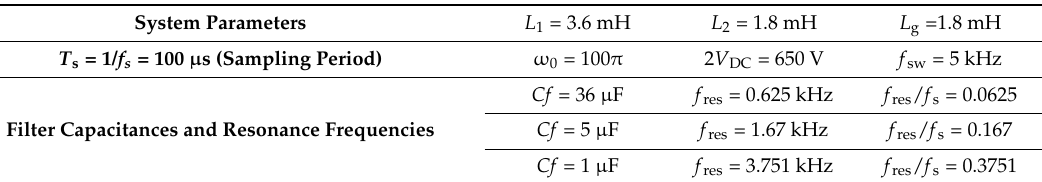
Table 1. LCL filter and inverter system parameters.